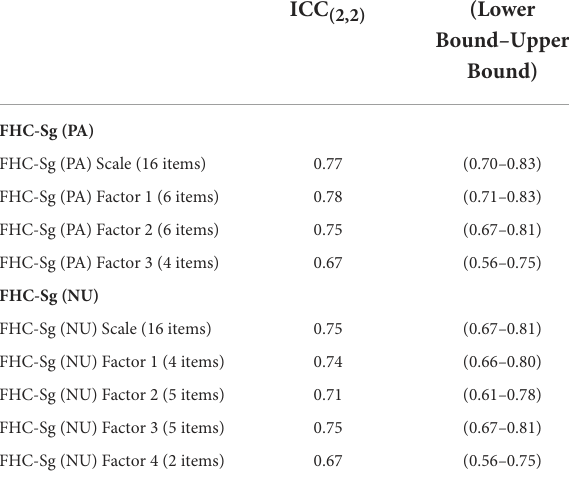
TABLE 13 Intraclass correlations (ICC) of FHC-Sg scales within family